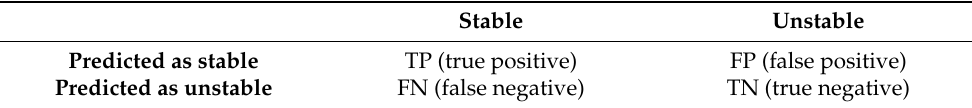
Table 2. Confusion matrix for binary classification